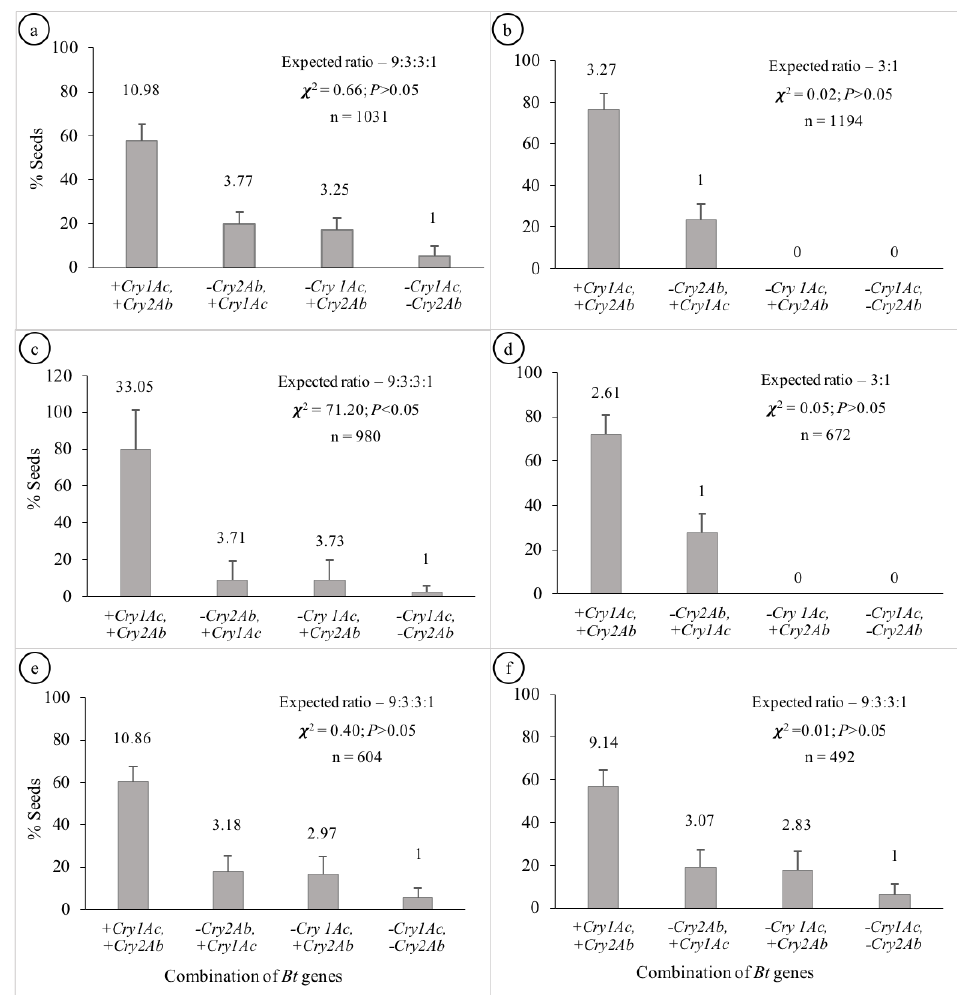
Figure 1. Segregation pattern of Cry genes in the seeds of the Bt cotton hybrids. [Segregation ratios are mentioned above the respective columns; ( a – f ) represent Hybrids 1 to 6, respectively].